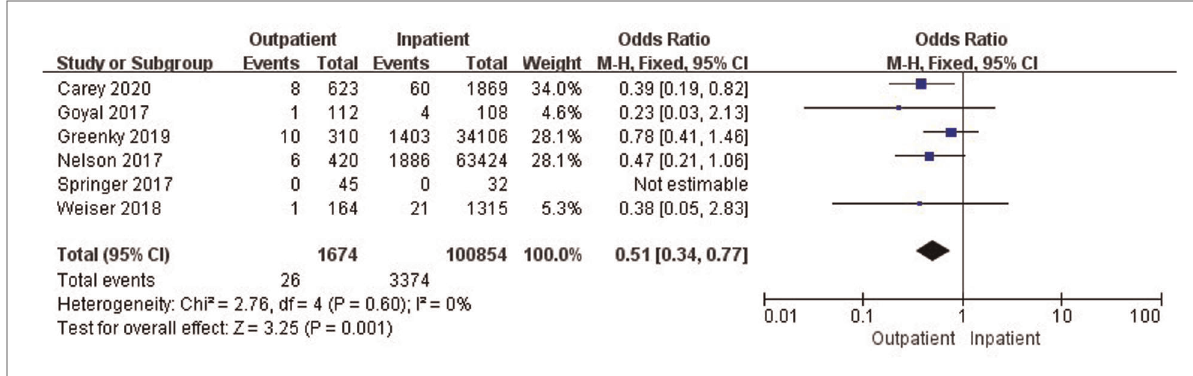
FIGURE 5 Comparison of 30-day readmissions between outpatient and inpatient THA.